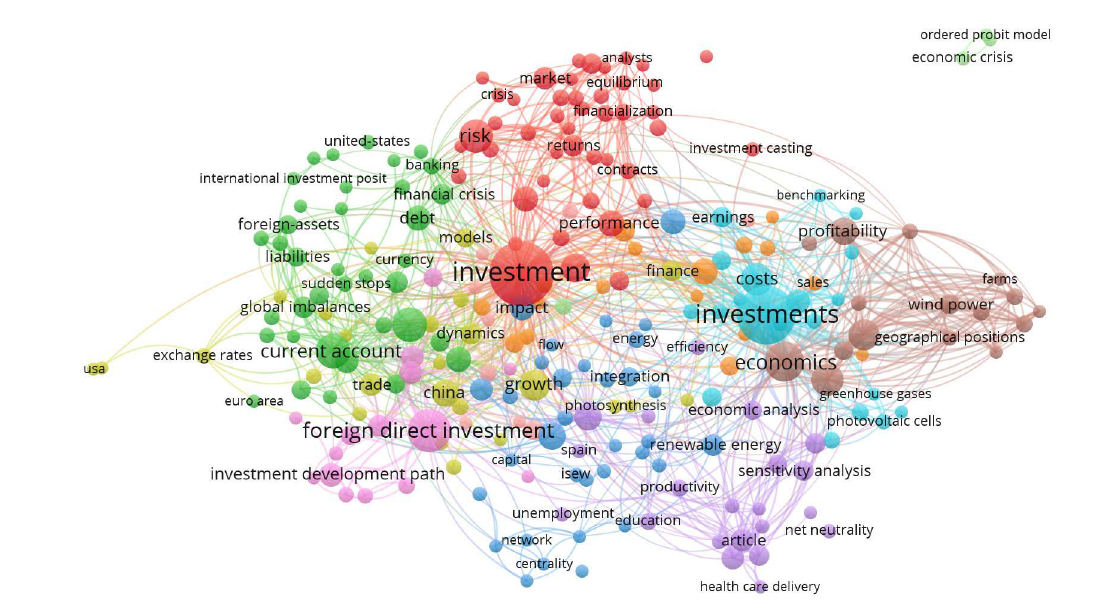
Figure A1. Bibliometric map of publications’ keywords on the query “Net international investment position” according to Scopus and WoS databases in 2000–2021